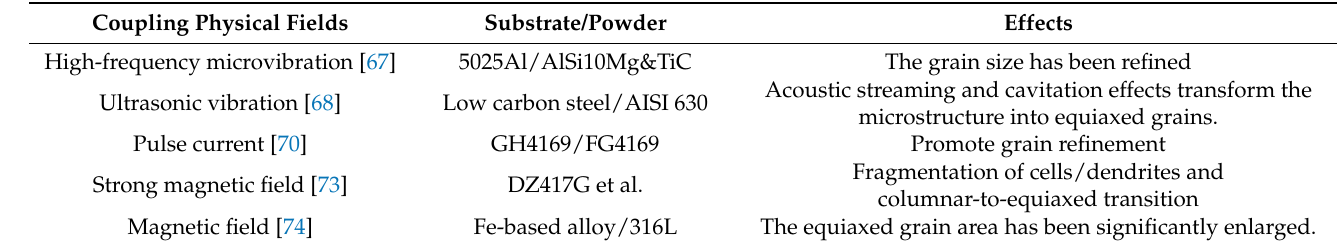
Table 1. The coupling of physical fields and its